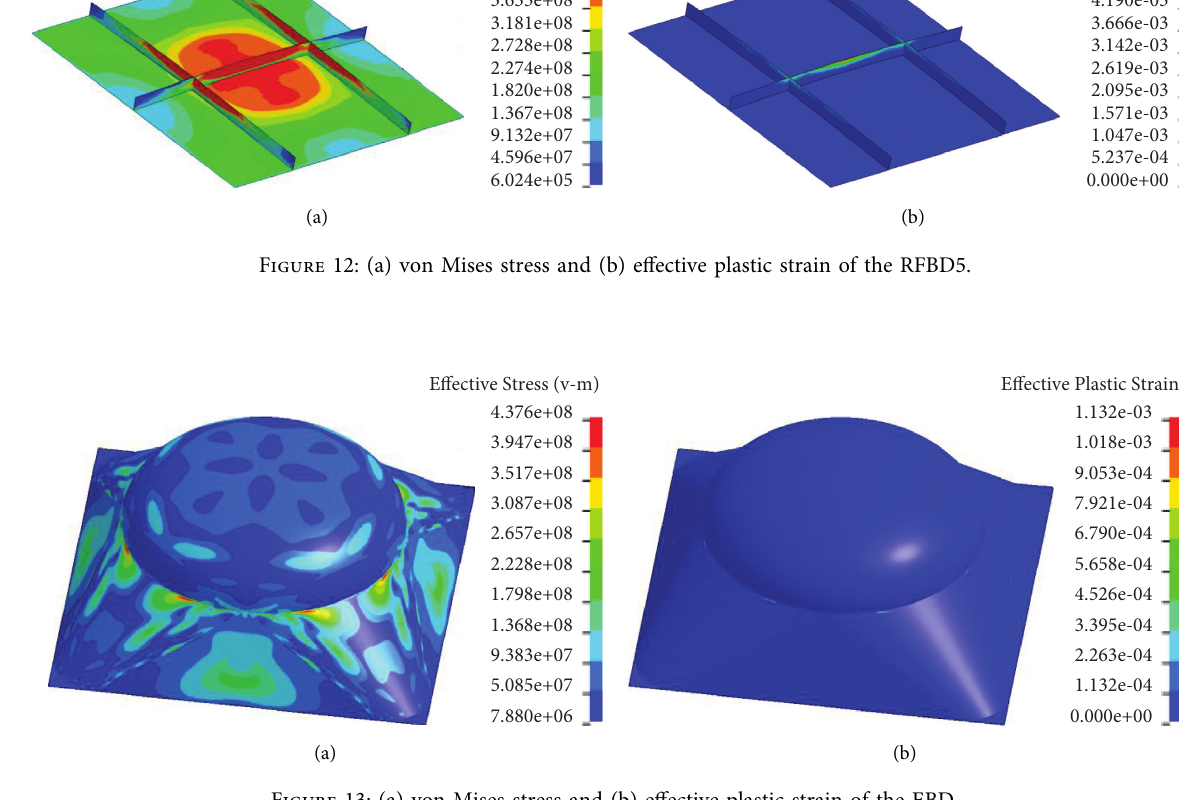
Figure 13: (a) von Mises stress and (b) effective plastic strain of the EBD.